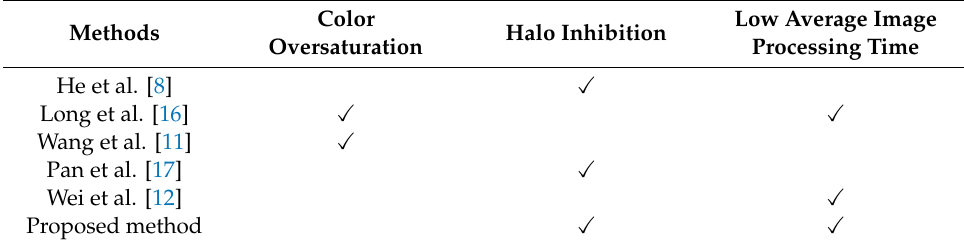
Table 6. The advantages and disadvantages using various